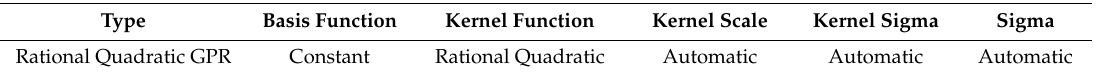
Table 2. The parameters of GPR.